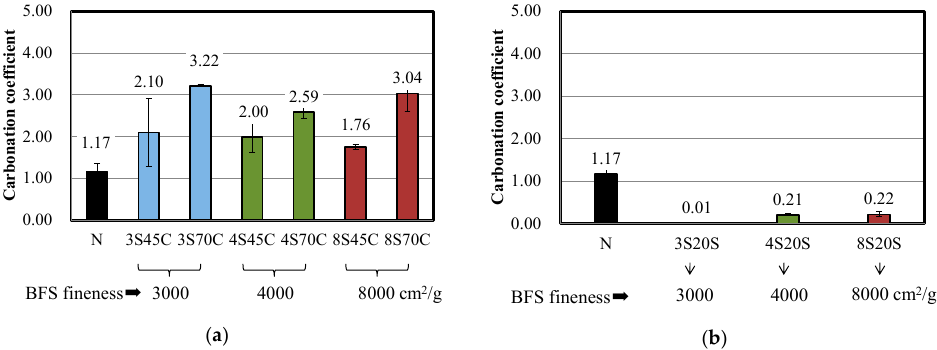
Figure 6. Carbonation coefficients for different mortar mixtures with and without BFS: ( a ) replacement of BFS for cement and ( b ) replacement of BFS for sand.